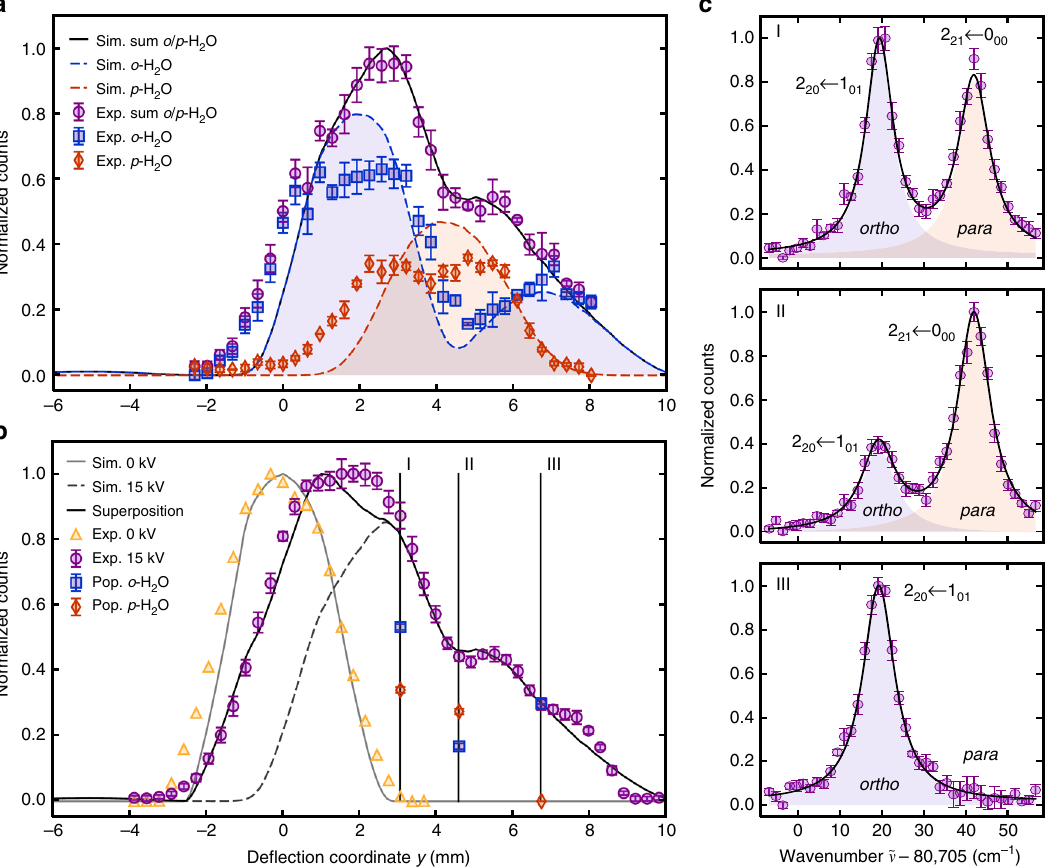
Fig. 2 Molecular-beam de fl ection pro fi les of the ground states of para and ortho- water. a Experimental isomer-speci fi c density pro fi les of o- (blue squares) and p- H 2 O (red diamonds) in the de fl ected molecular beam (de fl ector voltage 15 kV) measured by (2 + 1) REMPI together with the total de fl ection pro fi le (sum of the ortho- and para- signals, purple circles). The lines represent Monte-Carlo trajectory simulations of the de fl ection pro fi les. The contributions from ortho- and para- water are indicated by the blue and red shaded areas, respectively. b Total water de fl ection pro fi le measured by femtosecond-laser ionization for de fl ector voltages of 0 kV (yellow triangles) and 15 kV (purple circles). The three vertical lines marked I, II, and III indicate the de fl ection coordinates at which reaction rates were measured. The red/blue symbols represent the relative populations of the isomers normalized to the total signal at positions I, II, and III as determined from the REMPI spectra shown in c . c REMPI spectra of H 2 O measured at the three positions I, II, III (purple circles). The two peaks observed at 80,724 cm − 1 and 80,747 cm − 1 correspond to transitions from the ground states of ortho- and para- water, respectively. The peaks are fi tted with a sum of two Lorentzians (solid black line) with contributions from ortho- and para- isomers depicted as blue and red shaded areas, respectively. Error bars correspond to one standard error of at least three independent